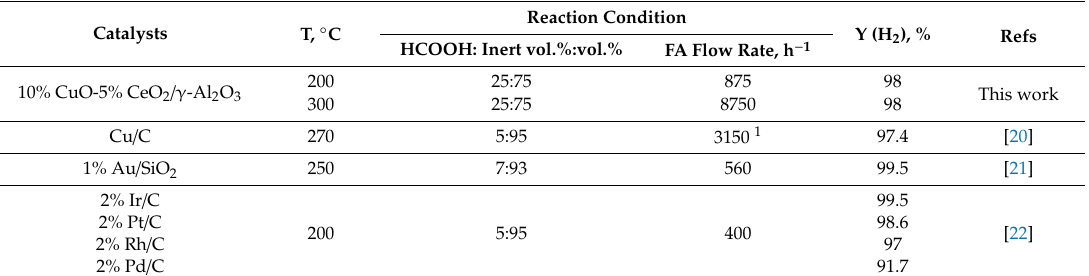
Table 2. Comparison of catalyst activities in formic acid decomposition.